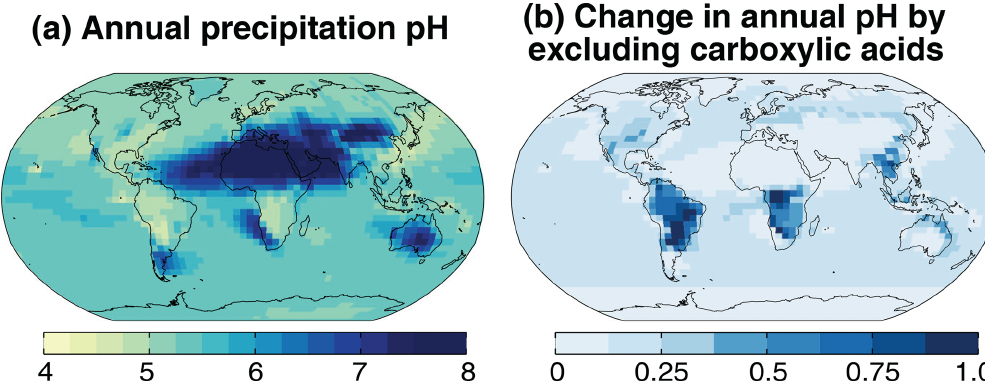
Figure 6. (a) Annual mean precipitation pH simulated by GEOS-Chem for 2013. Panel (b) shows the change in precipitation pH when [HCOO − ] and [CH 3 COO − ] are excluded from the ionic charge balance. See Sect. 2.3 for the procedure to compute average pH in the